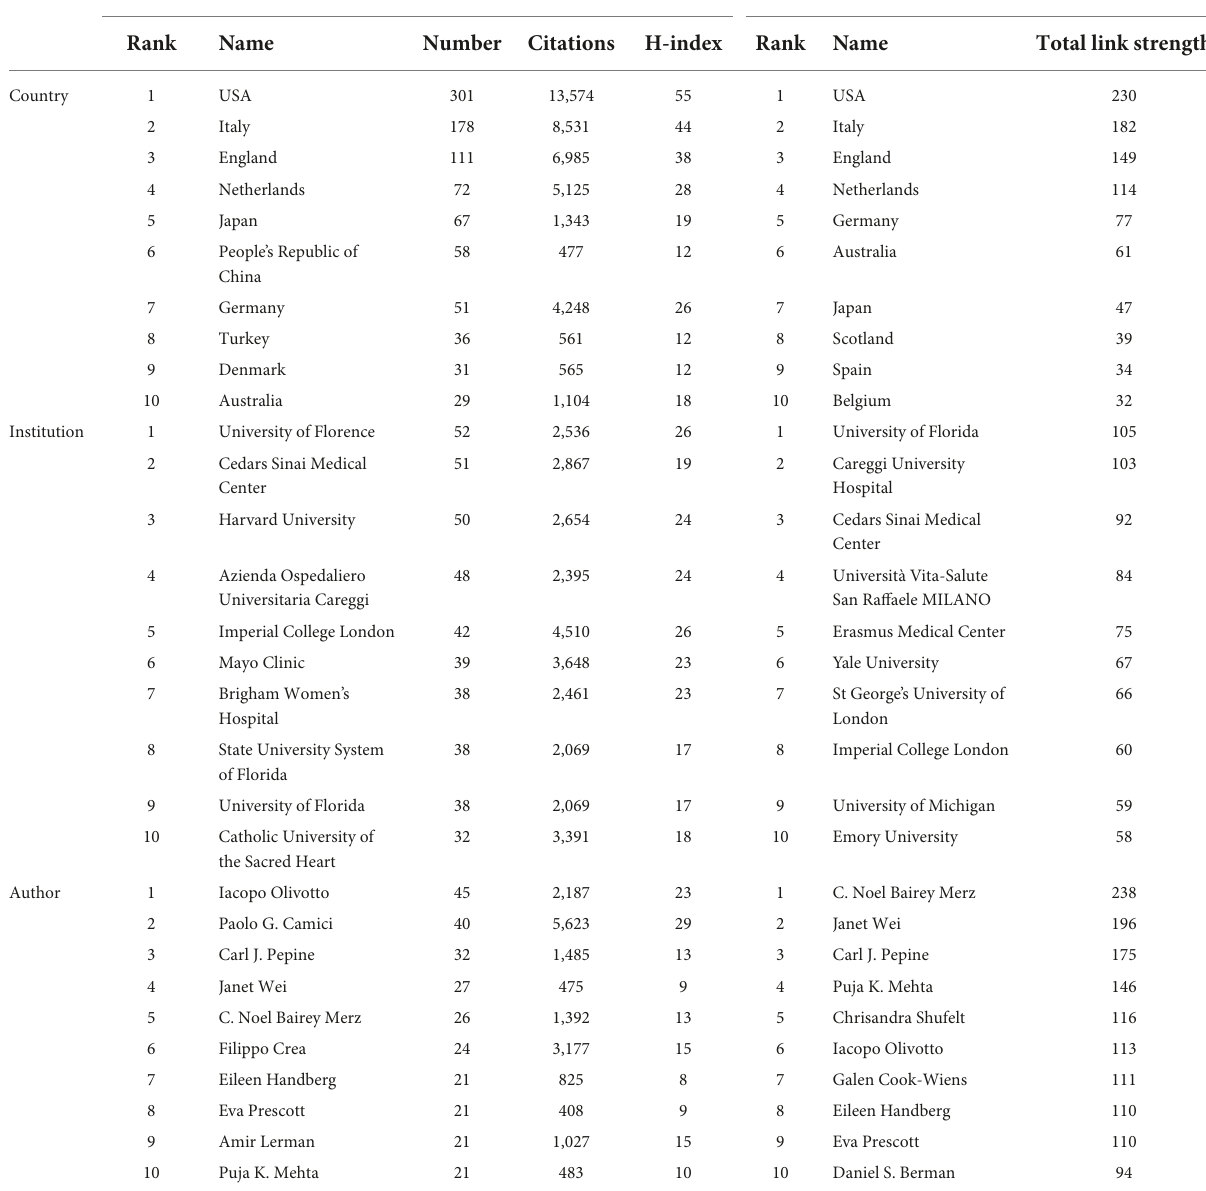
TABLE 1 Ranking of the top 10 authors, institutions, and countries based on publications.